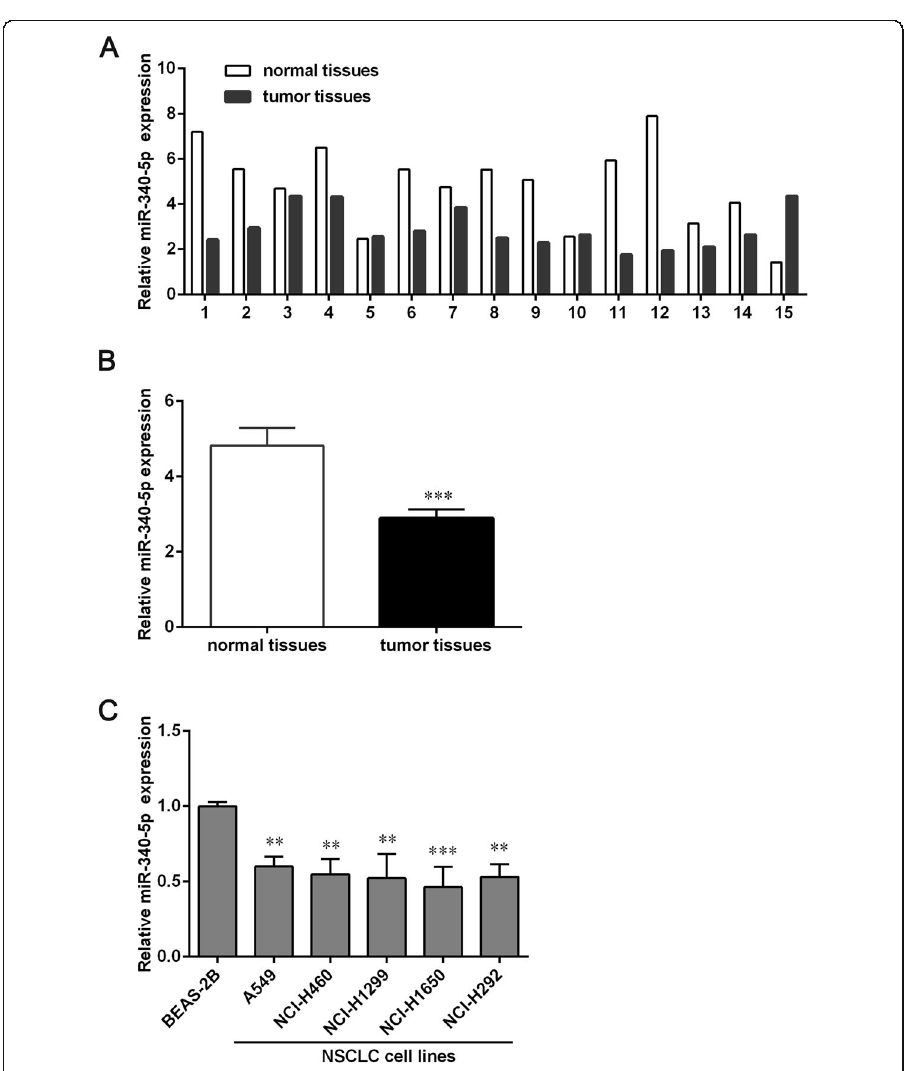
Fig. 1 Expression of miR-340-5p in NSCLC tissues and cell lines. a The mRNA levels of miR-340-5p in 15 paired NSCLC tissue and pericancerous normal tissue samples were determined using qPCR. b The expression of miR-340- 5p is significantly lower in NSCLC tissues than in normal lung tissues. c qPCR analysis of miR-340-5p expression in normal lung cells (BEAS-2B) and in five NSCLC cell lines (A549, NCI-H460, NCI-H1299, NCI-H1650 and NCI-H292) is shown ( n =3). Data are presented as the means ± SD. ** p <0.01 and *** p <0.001 versus the normal tissues group or the BEAS-2B